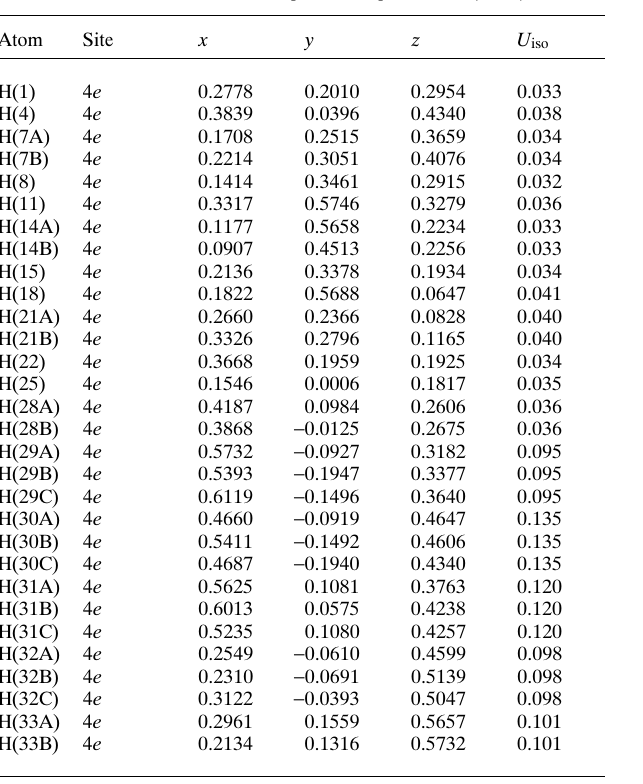
Table 2. Atomic coordinates and displacement parameters (in Å 2 ) .